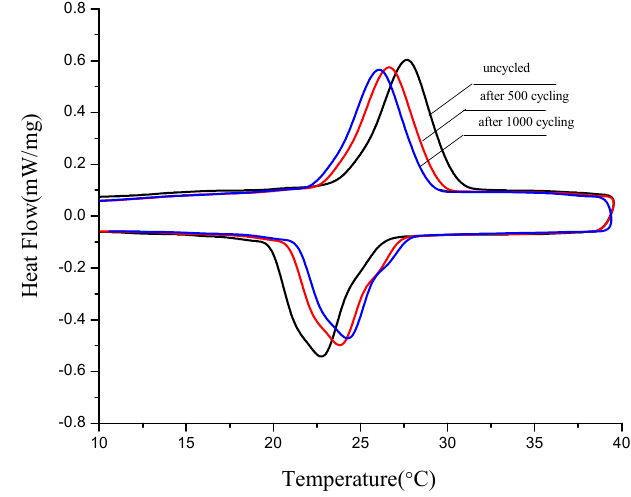
Figure 12. DSC curves of FS TD-LA PCM before cycling, after 500 and 1000 cycling.